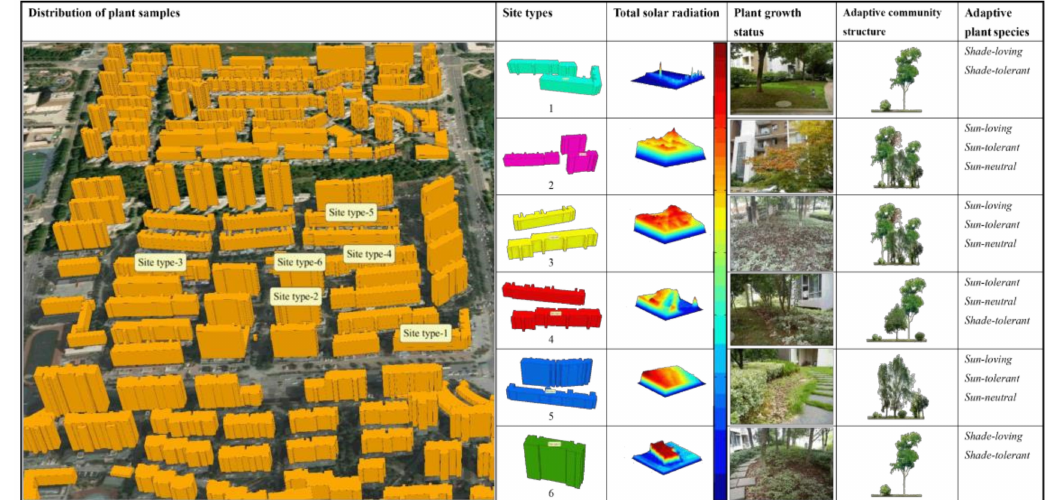
Figure 7. Optimization for landscape plant selection and community configuration based on the site types and solar simulation.